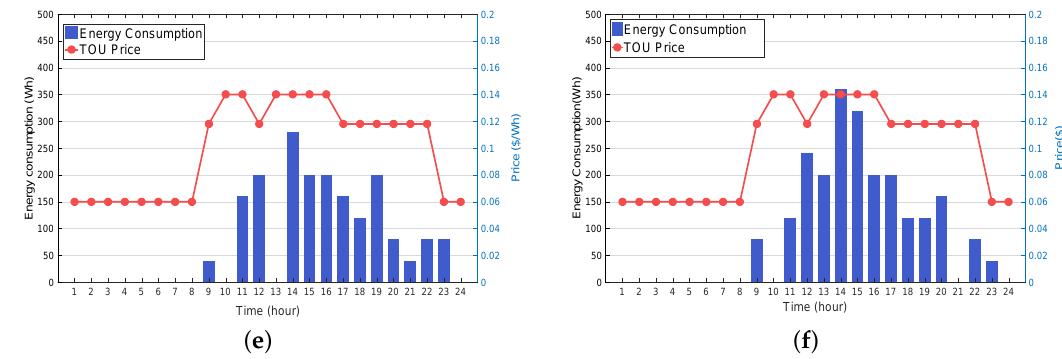
Figure 7. Impact of different penalties ( κ ) for AC scheduling on indoor temperature ( T in consumption ( E a , t ). ( a ) T in t with κ = 10; ( b ) T in t with κ = 50; ( c ) T in t with κ = 100; ( d ) E a , t with κ = 10; ( e ) E a , t with κ = 50; ( f ) E a , t with κ = 100.